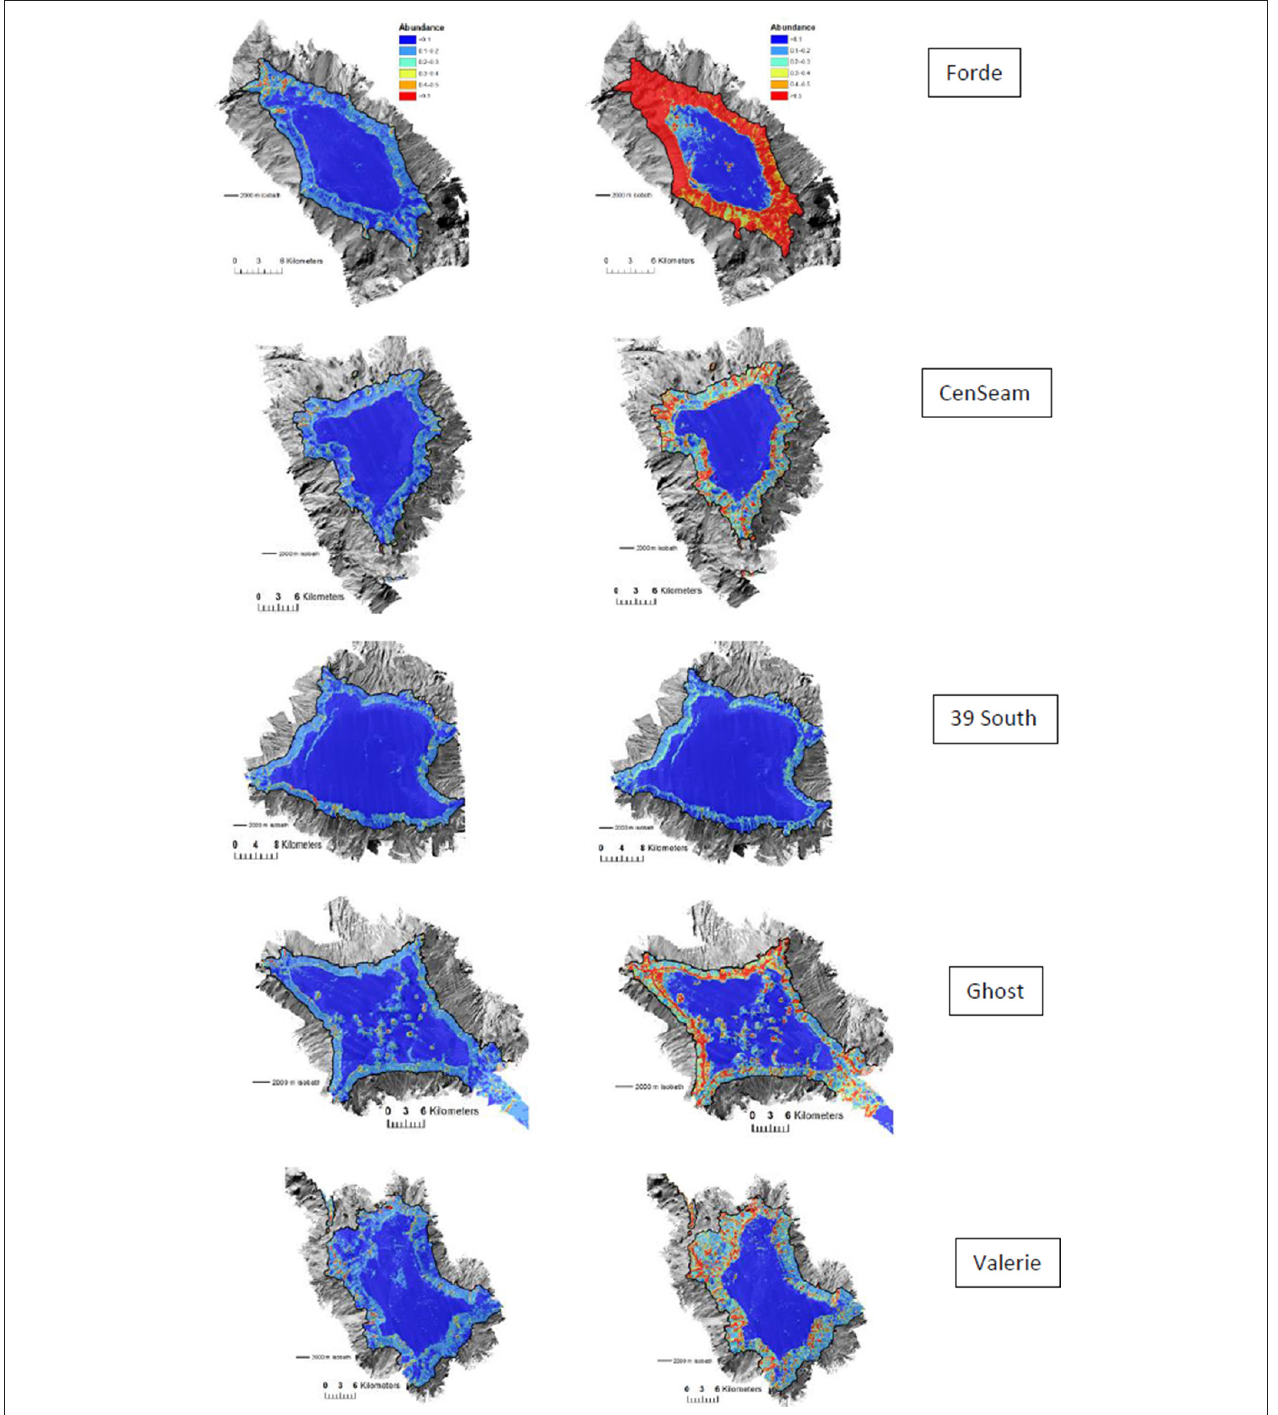
FIGURE 6 | Predictions of brisingids (Left) and crinoids (Right) abundance (number per 25 × 25m model cell) for ensemble habitat suitability model. Color-coded model abundance estimates are draped over the MBES bathymetry obtained during the survey.